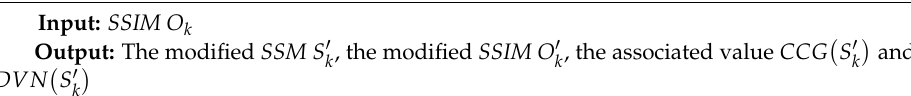
Algorithm 1. Group consensus improvement